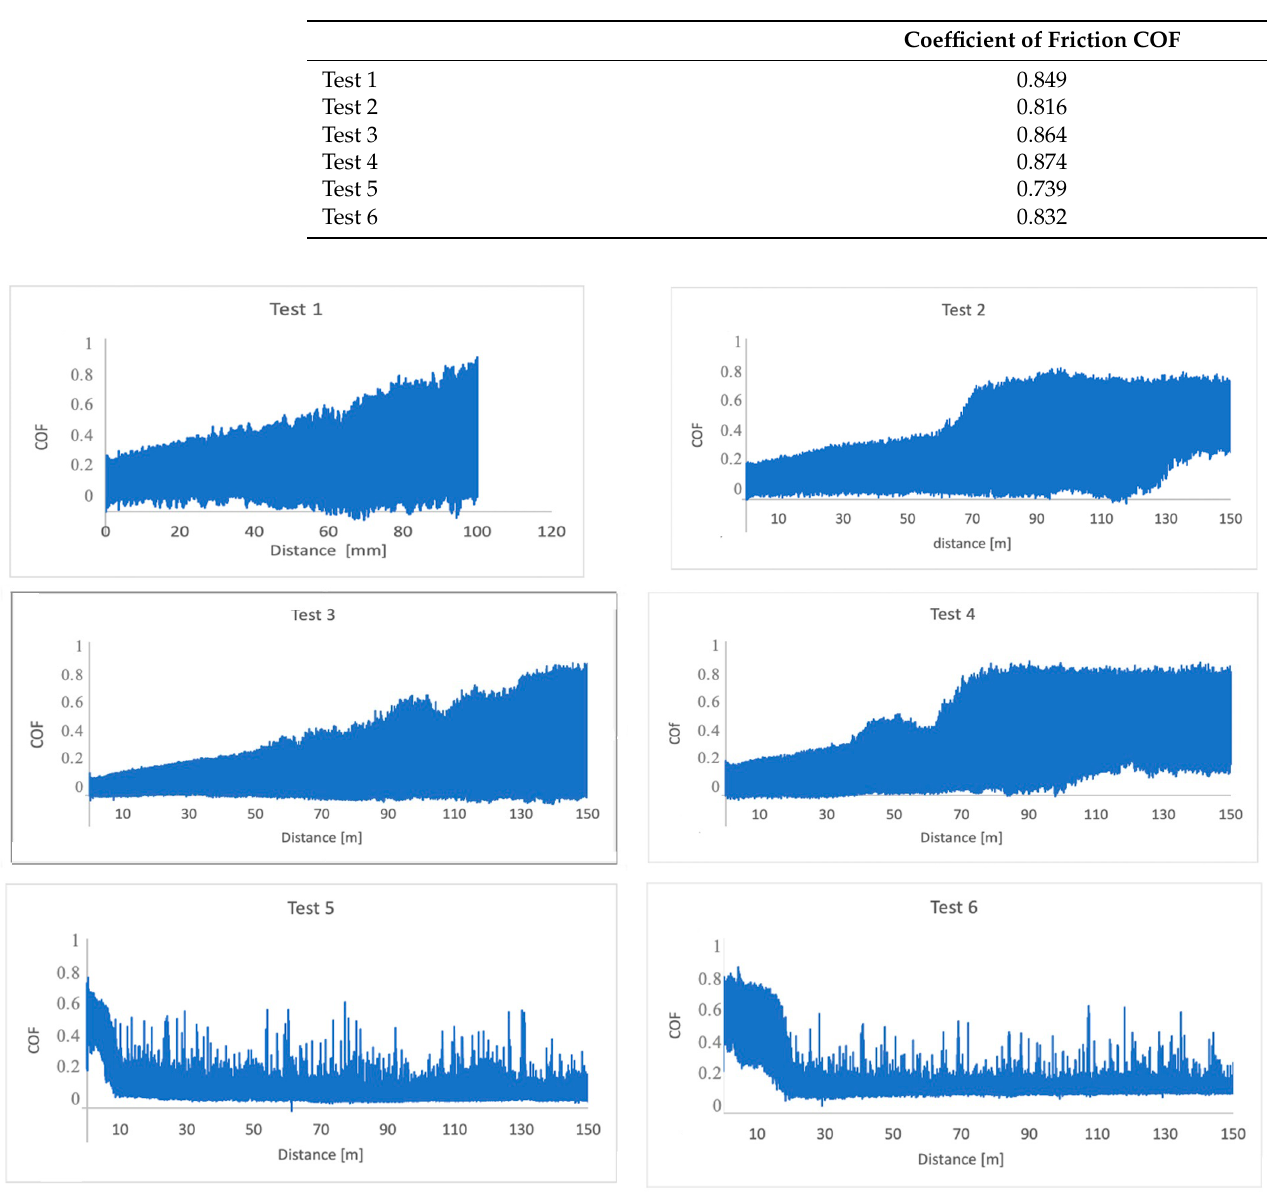
Figure 15. Trend of COF during test for DMMC ( first and second row ) and D30 ( third row ).